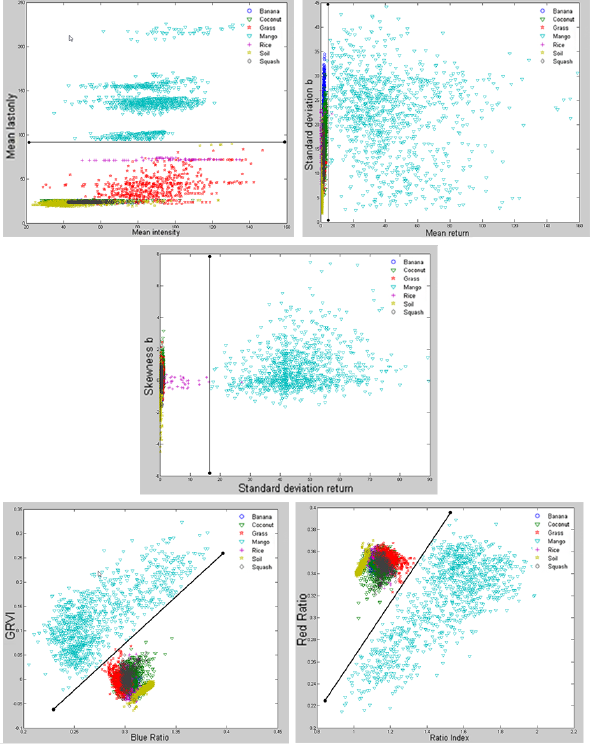
Figure 4. Distinguishable separation of samples applying the concept one versus